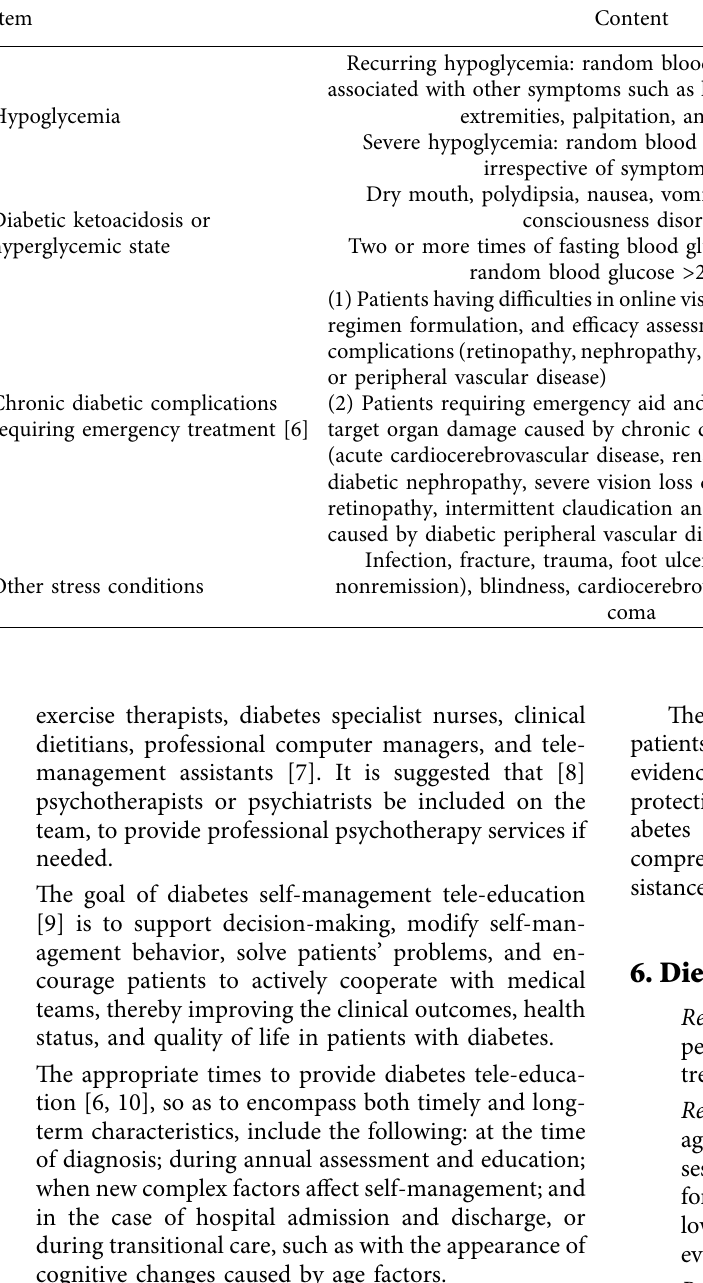
Table 2: Conditions that require referral for an offline or emergency